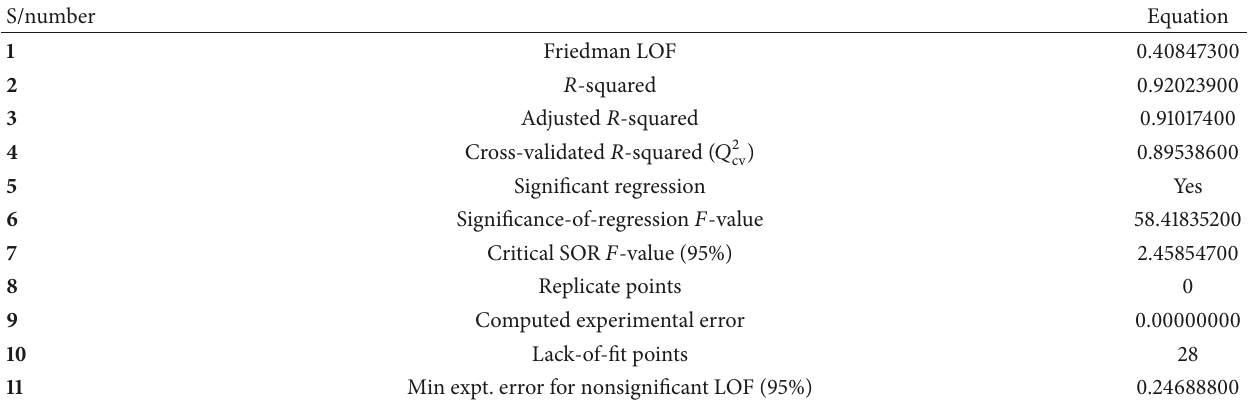
Table 4: Validation of the genetic function approximation from Materials Studio.